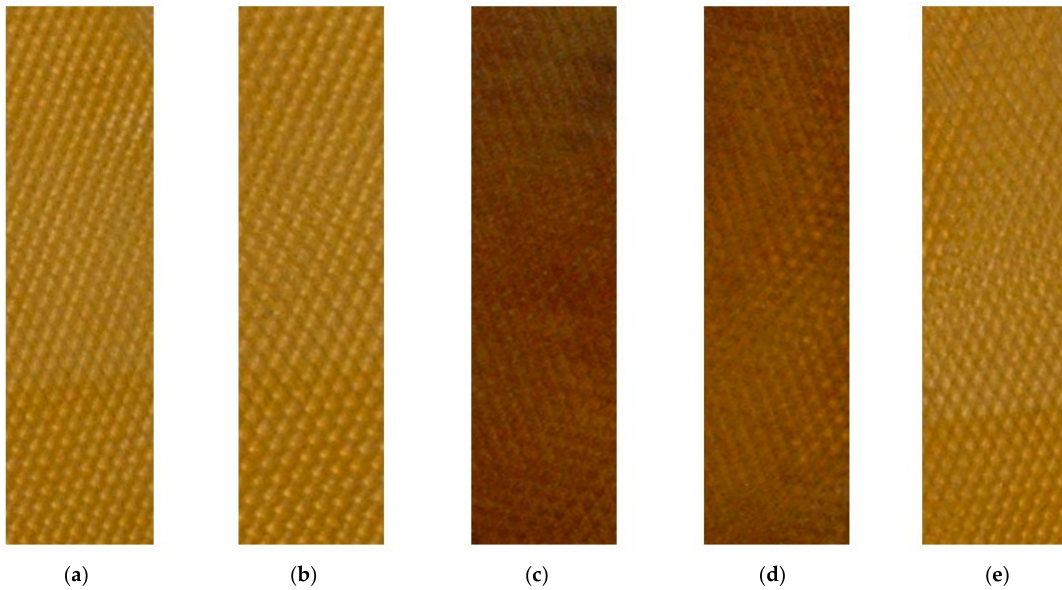
Figure 8. The color of each experimental sheet sample and the referent for ( a ) para rubber wood vinegar; ( b ) acetic acid; ( c ) bamboo wood vinegar; ( d ) coconut shell wood vinegar; and ( e ) the referent.